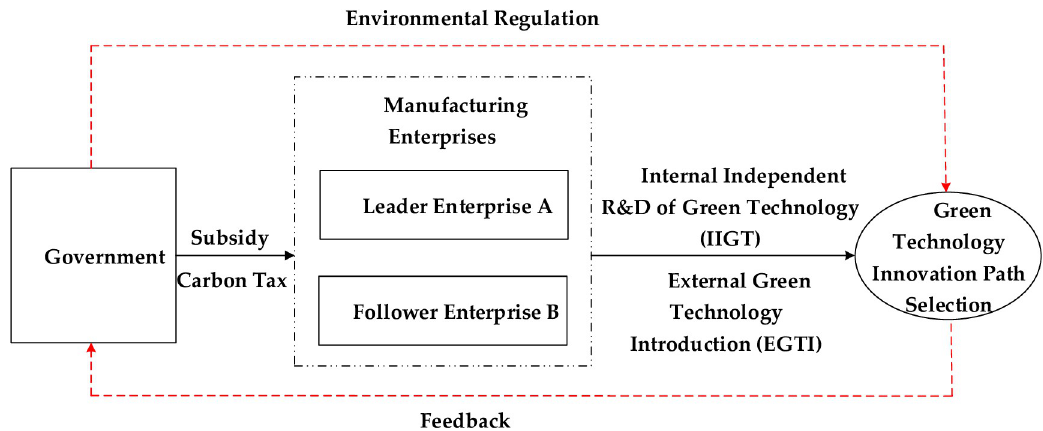
Fig 3. Illustrations of the game relationship among the government, the leader enterprise A and the follower enterprise B.